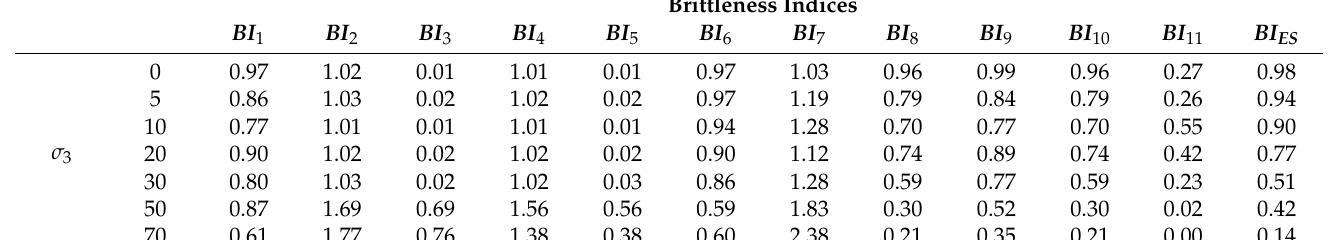
Table 7. Calculated results of various brittleness indices based on shale CTC test data.